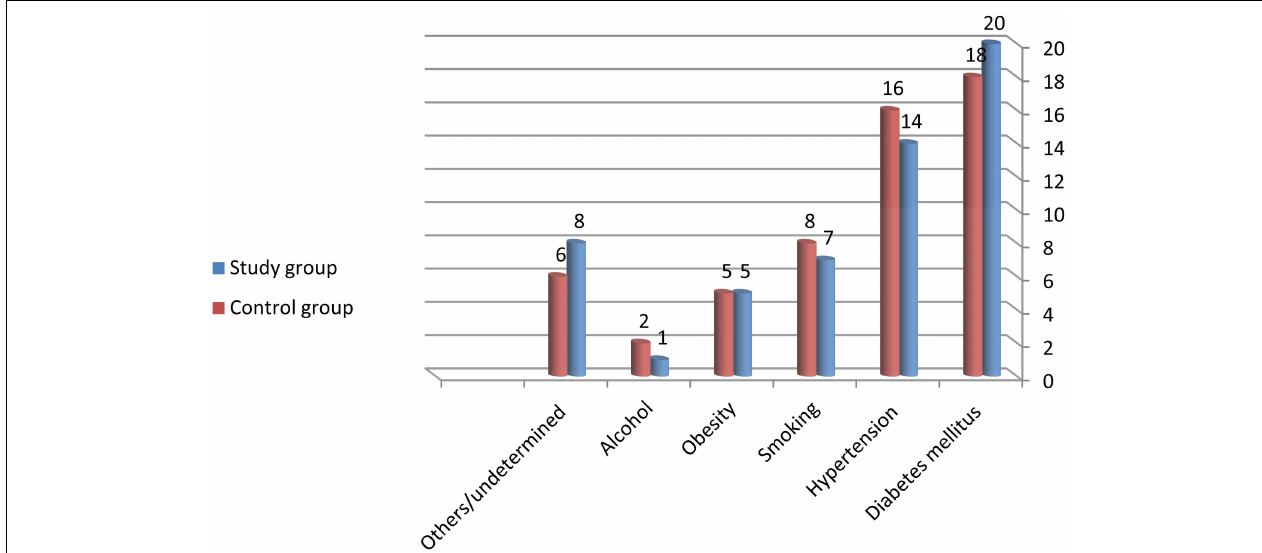
FIGURE 1 | Different causes of the hyperlipidemia in the study and control